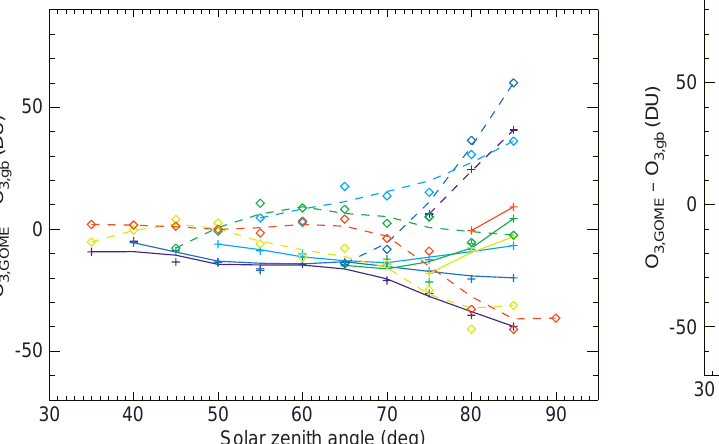
Fig. 5. Deviation of GOME total ozone from GUV values, averaged in 5-degree SZA intervals for all months of the 1-y period investigated. Crosses/solid lines : July–December 1996, diamonds/dashed lines : January–June 1997. Lines: 3-point running mean. Colour code: violet, dark blue, light blue, green, yellow-green, red for subsequent months